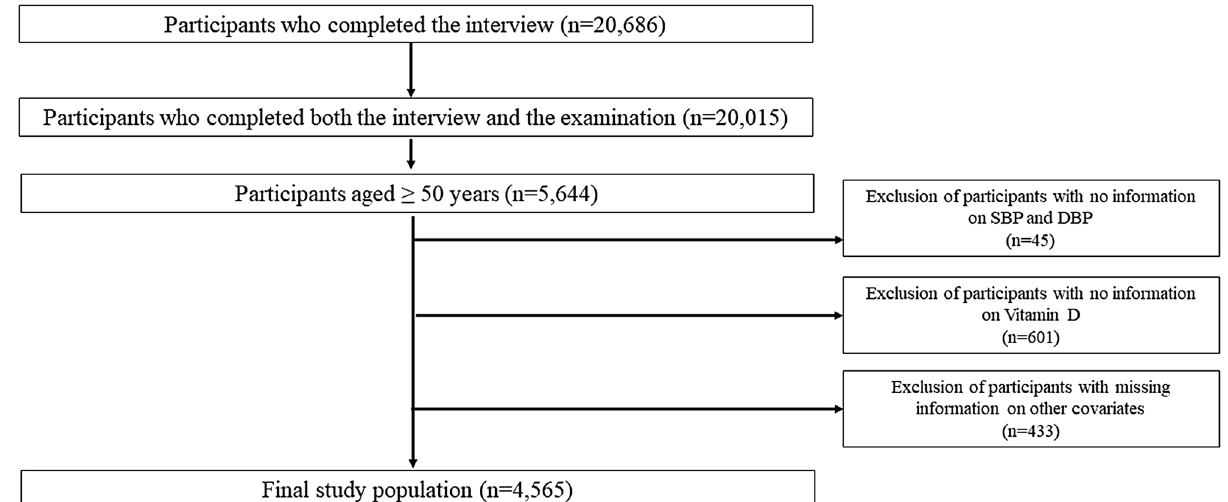
Figure 3. Description of the study